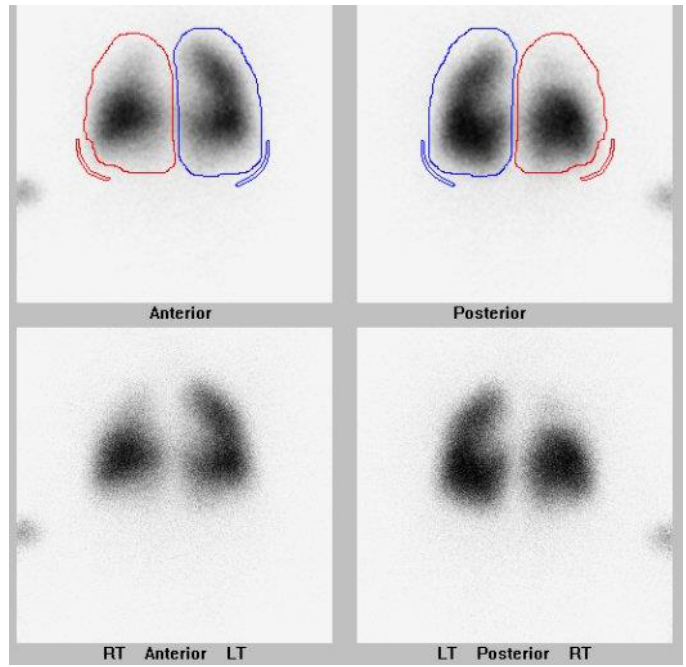
Figure 1. Nuclear lung perfusion scan of a 6 month old patient with a history of bilateral upper pulmonary vein stenosis. Image is pre-intervention. Differential pulmonary perfusion as quantitated based on Tc-99m MAA localization is 56% left and 44% right lung. There is decreased perfusion to the right upper lung. Right lung is outlined in red. Left lung is outlined in blue.